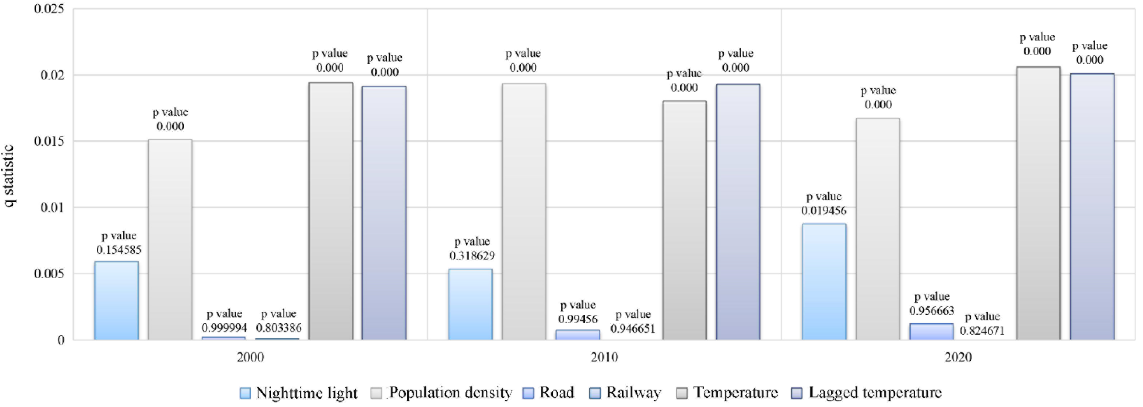
Figure 9. Q statistic and p ‐ value of the factor detector